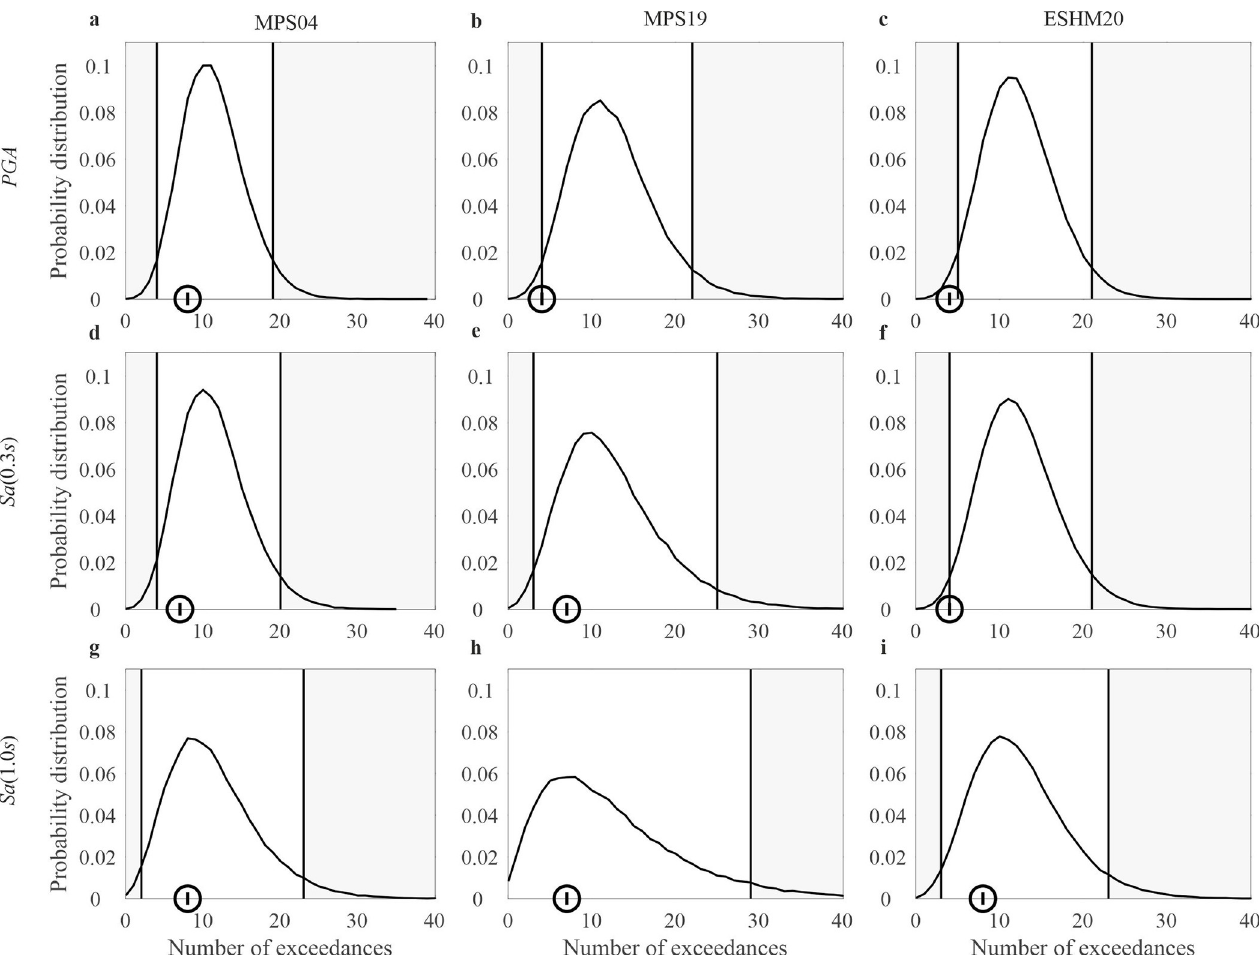
Fig 6. Results of the tests for T = 475 yr . Distribution of the total number of exceedances from 1973 to 2019 of the ground motion intensity with T r 143 sites where continuously recording stations have been present, each in a time period, and total observed exceedances at the same stations. The panels in the same columns refer to the same model: (a), (d), (g) are from MPS04; (b), (e), (h) are from MPS19; (c), (f), (i) are from ESHM20. The panels in the same row refer to the same IM : (a), (b), (c) are PGA ; (d), (e), (f) are Sa (0.3 s ) ; (g), (h), (i) are Sa (1.0 s )